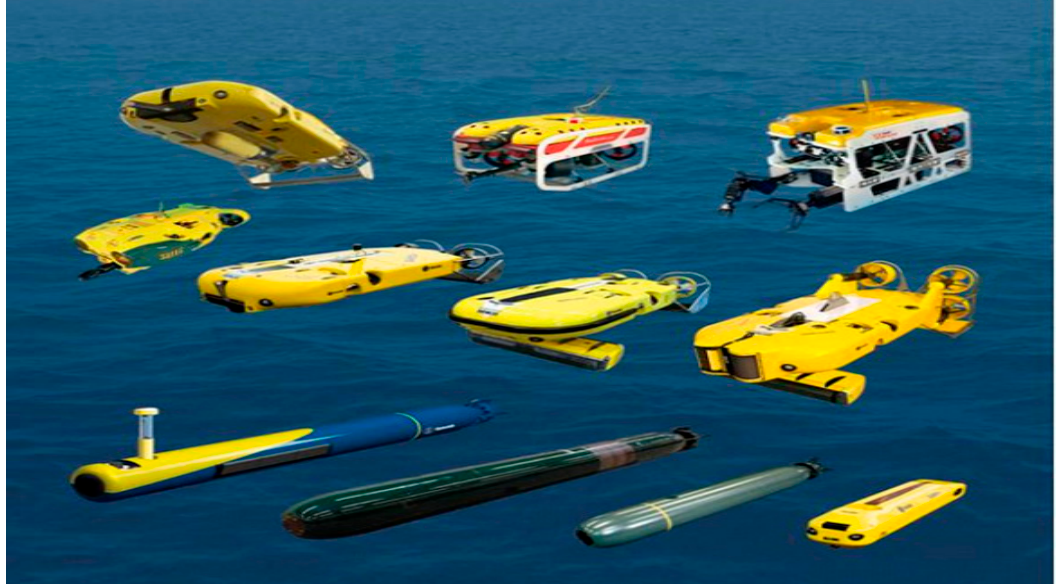
Figure 7. Different kinds of AUVs and ROVs [116]. Figure 7. Di ff erent kinds of AUVs and ROVs